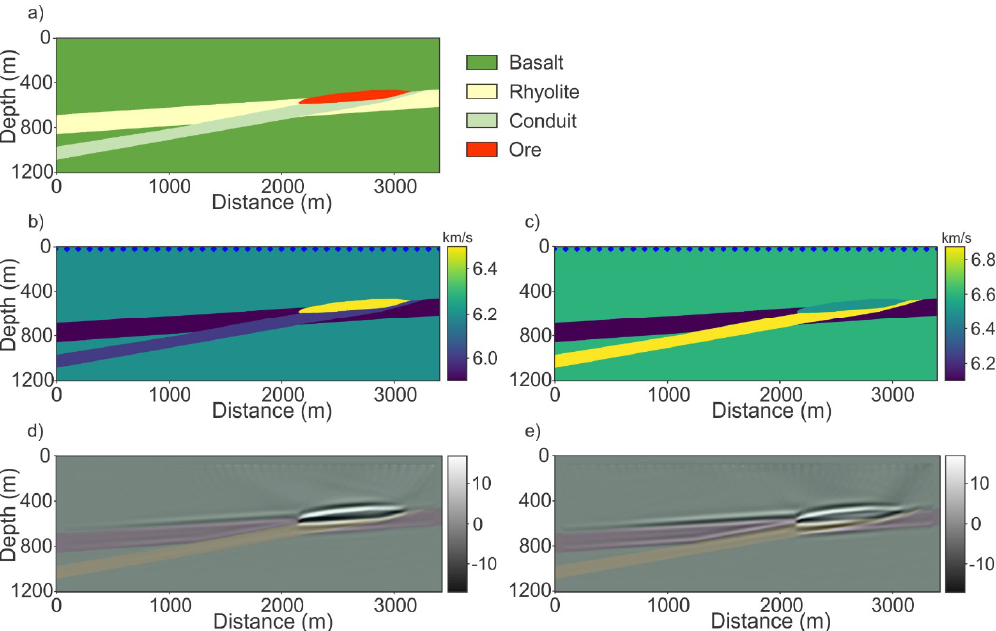
Figure 9. Models used for seismic synthetics. ( a ) Model of a VMS deposit with a subconcordant hydrothermal conduit; ( b ) P-wave velocity model for greenschist facies conditions; ( c ) P-wave velocity model for amphibolite facies conditions; ( d ) processed seismic forward modeling profile for greenschist facies conditions; ( e ) processed seismic forward modeling profile for amphibolite facies conditions. See text for details on the modeling procedure. Table 6. Major oxide analyses from the footwall hydrothermal alteration zone .